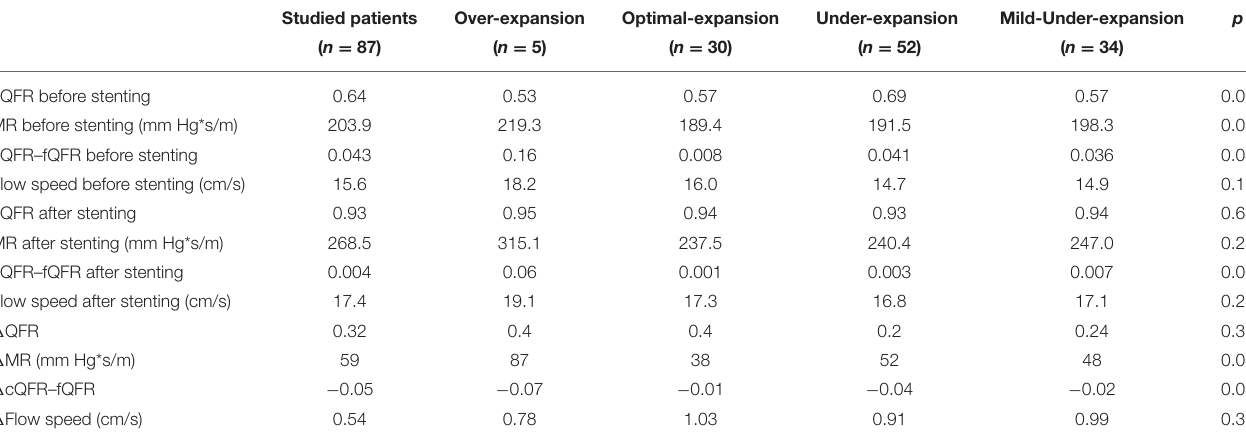
TABLE 2 | QFR characteristics.